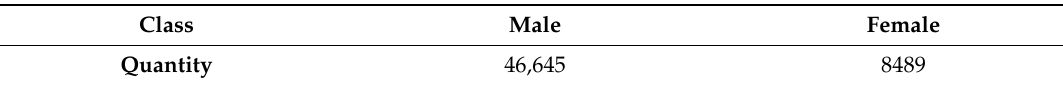
Table 7. Genders in the Morph database.